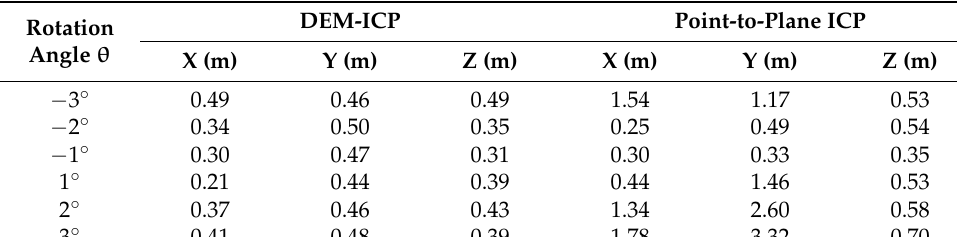
Table 5. R MSE of selected points in the three directions of XYZ. Table 5. RMSE of selected points in the three directions of XYZ.